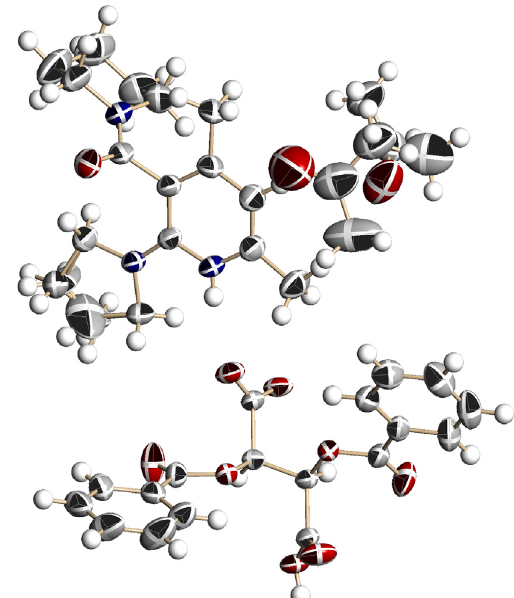
Figure 6. Packing diagram of (a S )- 1b /( − )- L -DBTA/2 acetones from the a axis. Two types of hydrogen bond were observed: (a) NH (pyridinium)---O=C (DBTA): 2.01 Å,